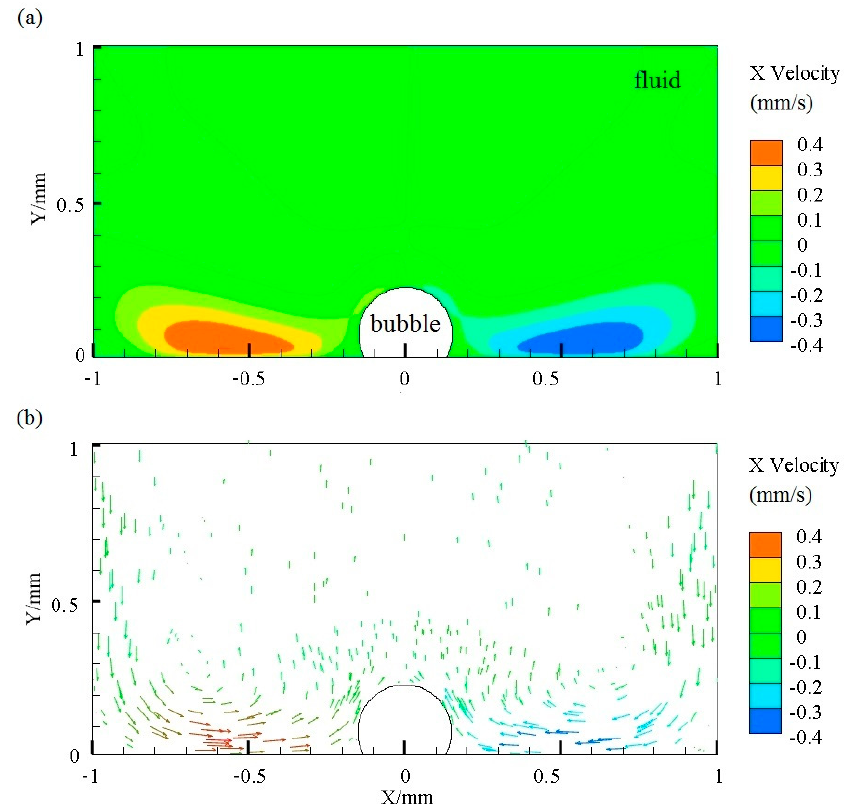
Figure 4. ( a ) Contours of X-velocity of the flow; ( b ) vectors of the flow. The simulation is conducted by ANSYS Fluent software. The diameter of the bubble is 236 µ m, the size of the liquid zone is 2 mm × 1 mm, and the frequency and displacement of vibration is 10 kHz and 5 µ m, respectively.